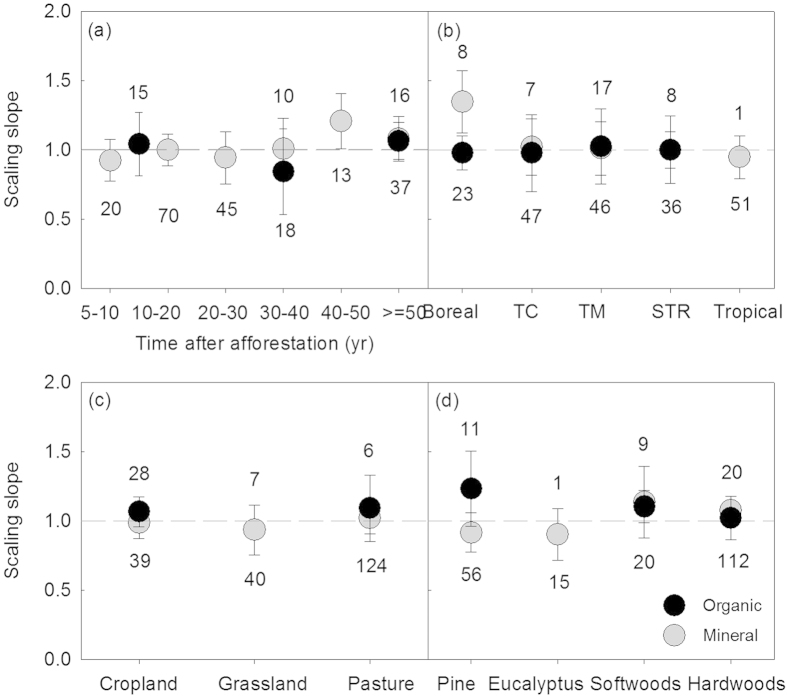
Variation in the scaling slopes of the N-C stoichiometric relationships over the age sequence (a) and among different climate zones (b), land use types (c), and plantation species (d) following afforestation. For the organic horizon in panel (a), the data were grouped into 5–20, 20–50, and ≥50 yr due to the limited number of observations. The scaling slope indicates the slope of the type II (i.e. reduced major axis, RMA) relationship between log-transformed N and C. The error bar shows the 95% confidence interval of the scaling slope of the relationship between log N and log C. The dash line denotes the scaling slope is equal to 1.0. The missing value in panel (c) for the grassland was due to r2 = 0.33 and P = 0.18 > 0.05 of the correlation between the log-transformed N and C but in panel (d) was because of the limited number of observations for the organic horizon. The values showed above and below the 1.0 line in each panel represent the number of observations for the organic and the mineral soil horizons, respectively. TC: temperate continental; TM: temperate maritime; STR: subtropical.